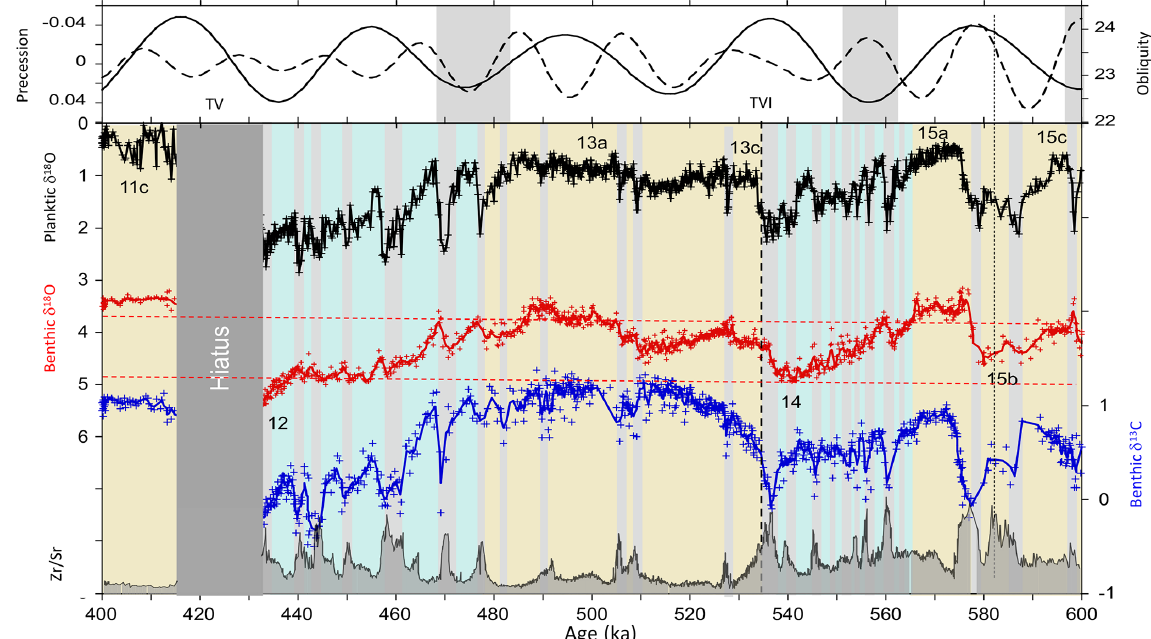
Figure 8. Same as Fig. 6 but for 400–600ka. A hiatus indicated by dark grey band has removed Termination V and early MIS 11.